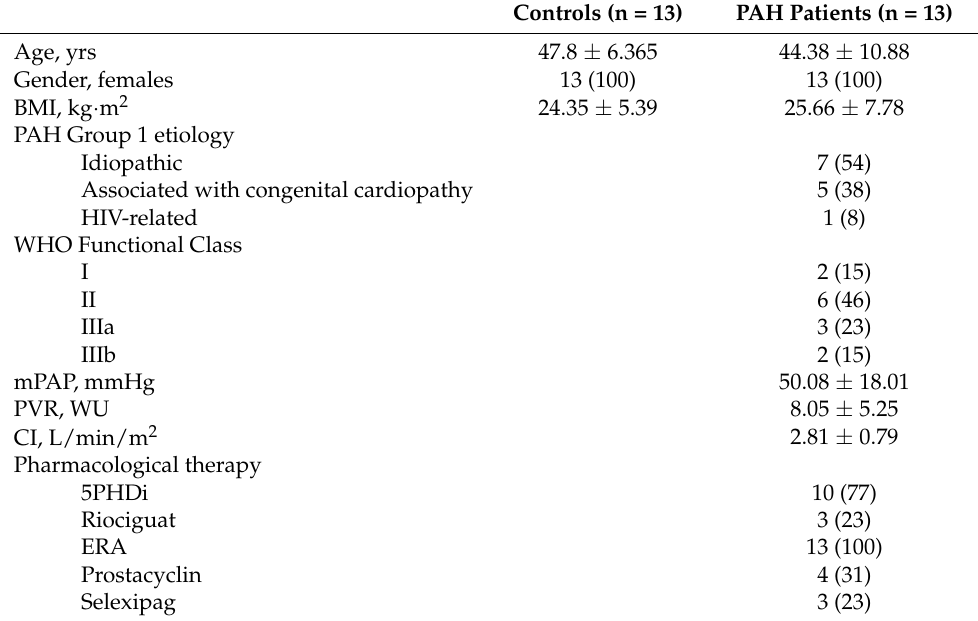
Figure 1. Comparison of the SUDS scale scores in healthy controls and PAH patients during the experimental sessions. The bar graphs show the Subjective Units of Distress Scale (SUDS) scores in healthy controls (black bars) and in PAH patients (white bars) at the end of the resting condition (Baseline) and after each of the three di ff erent blocks of the Montreal Imaging Stress Test (MIST1, MIST2 and MIST3). Results are presented as mean ± standard deviation. * indicates p < 0.05 vs. Base- line in the control group, and § indicates p < 0.05 vs. Baseline in the PAH patients’ group.